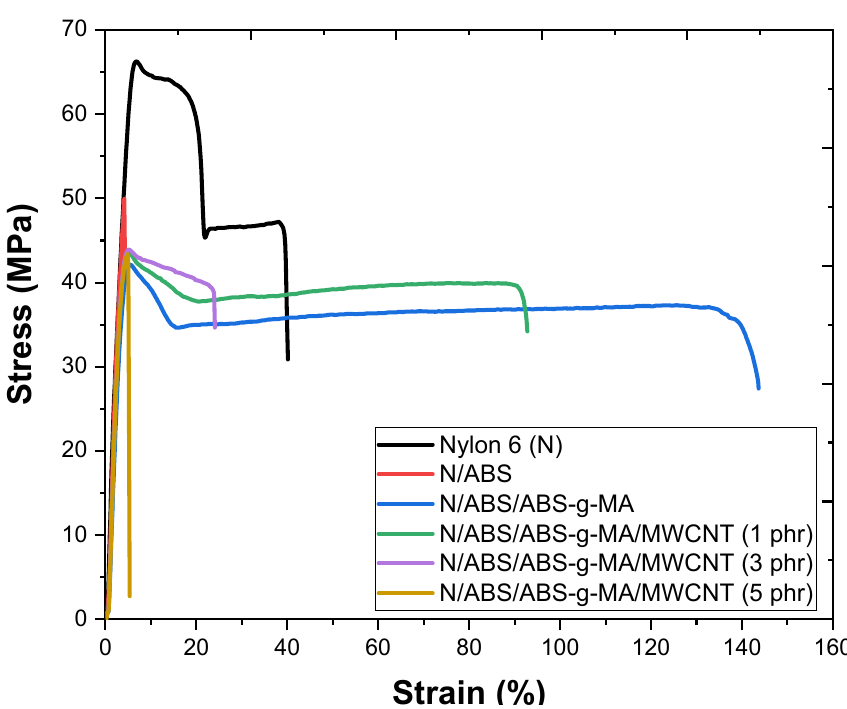
Figure 11. Stress-strain curves of Nylon 6, blends, and nanocomposites as a function of MWCNT concentration. N = Nylon 6.